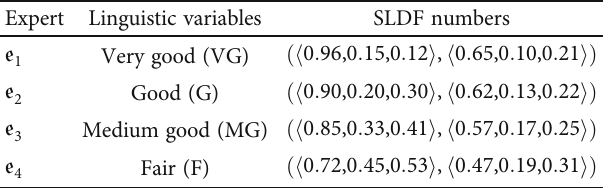
Table 5: Aggregated SLDF decision table.